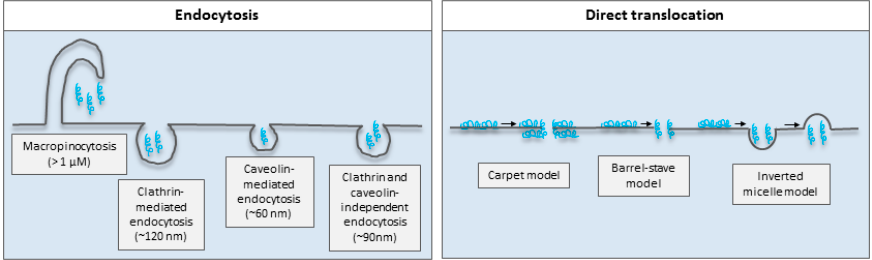
Figure 2. Simple illustration of mechanisms by which cell-penetrating peptides have been suggested to traverse the plasma membrane by endocytosis or direct translocation. Dimensions are obtained from [77]. Modified from [96] with permission from Elsevier. Blue helixes represent the CPPs, the arrow the uptake process subsequent to membrane interaction.